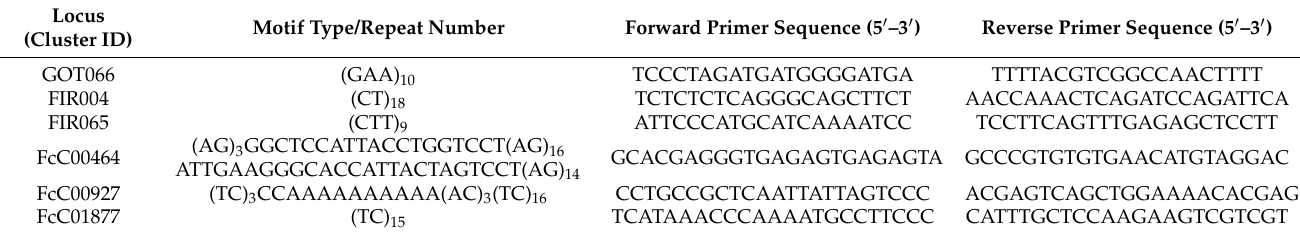
Table 1. Characteristics of 6 simple sequence repeat (SSR) markers